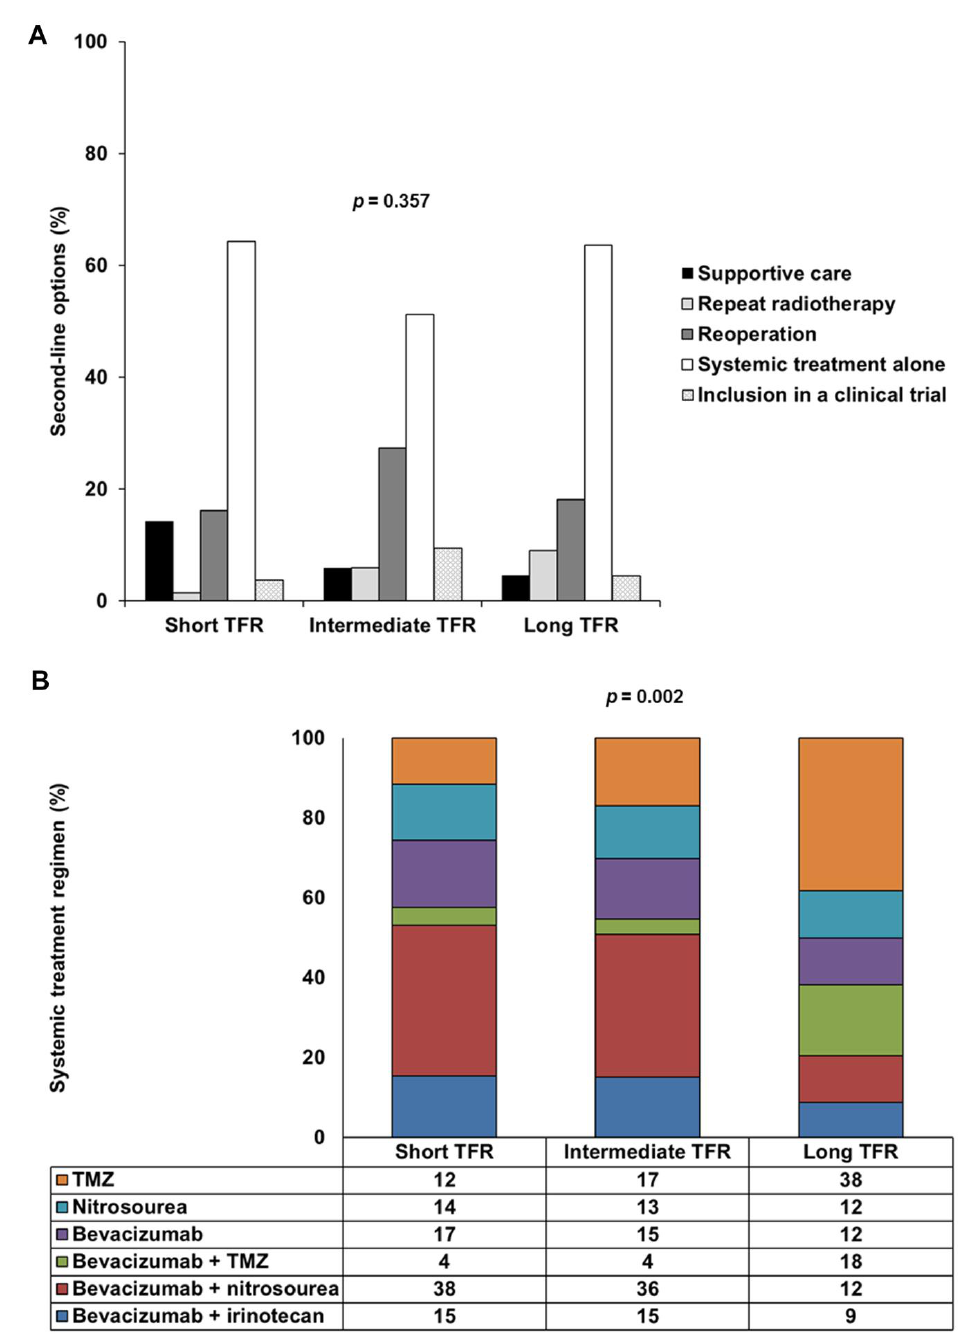
(Table 3). Older age, being male and a short TFR (vs. long TFR) tended to be associated with a poorer OS2 ( p = 0.094, p = 0.097 and p = 0.089, respectively).